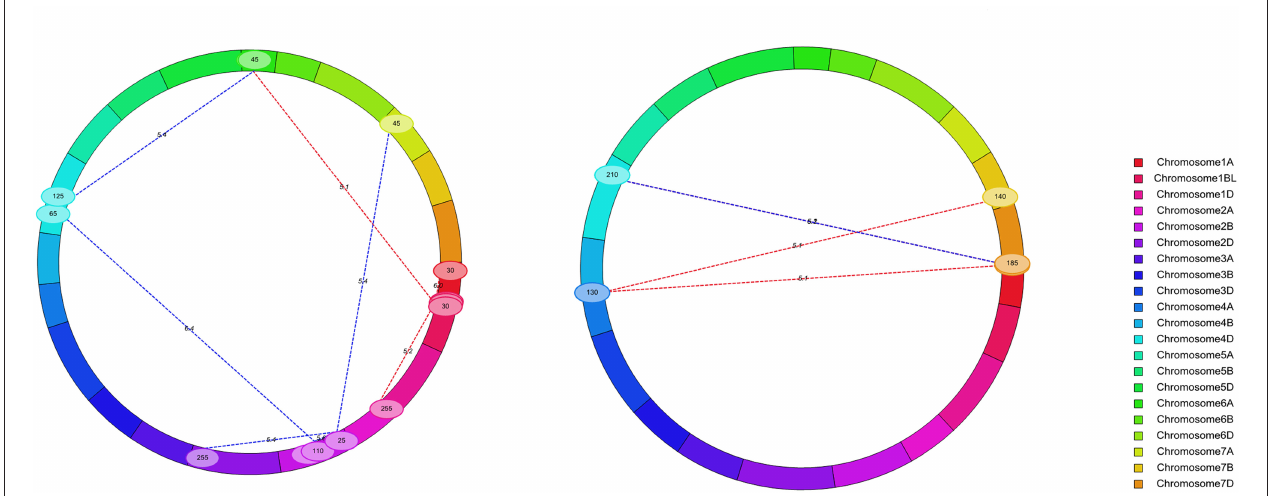
FIGURE 3 | Chromosomal locations of digenic epistatic QTL for KC (left) and KA (right). A total of nine digenic epistatic QTLs of KC and four digenic epistatic QTLs of KA were mapped, respectively.